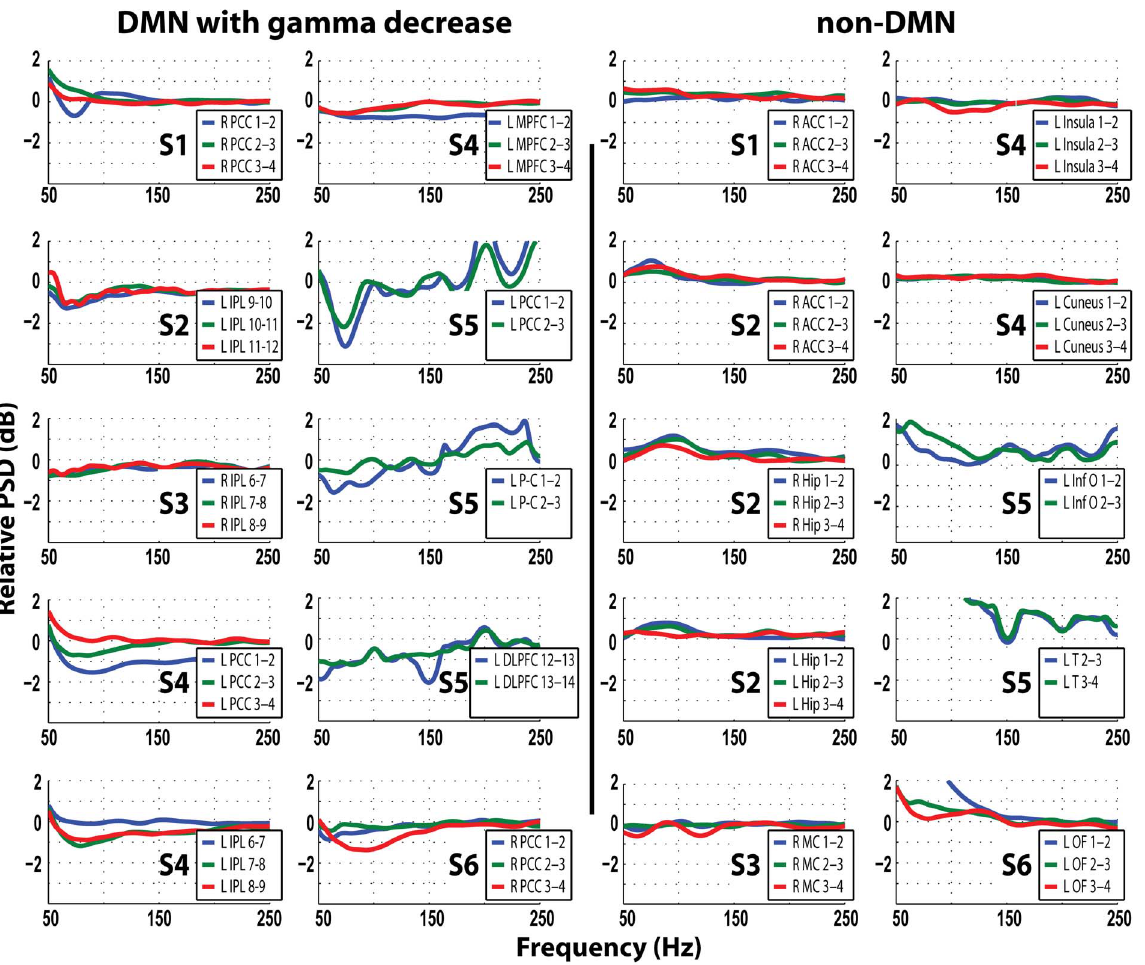
Figure 5. Relative power spectral density in dB, for frequencies 50–250 Hz. Power spectra in the DMN regions with gamma decrease and the non-DMN regions in all patients comparing 1 s epochs at the center of IED to baseline. Blue trace is the most medial, followed laterally by the green and red traces. S1–S6 relates to patients 1–6. Note the consistency of gamma decrease in DMN regions and the lack of similar spectral changes in non-DMN